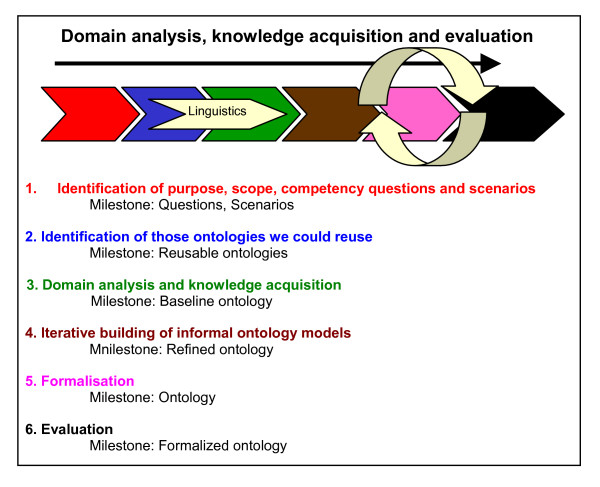
Steps (1–6) and milestones (boxes).